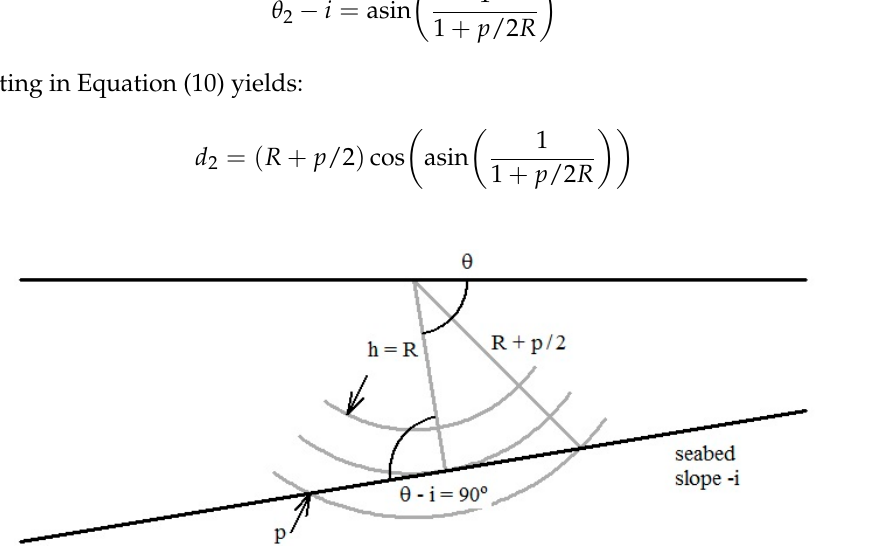
Figure 3. Geometry of acoustic rays for a sonar pulse intersecting the seabed for the condition R = h . Along-trace side view. The direction of the sonar vehicle is into the page.